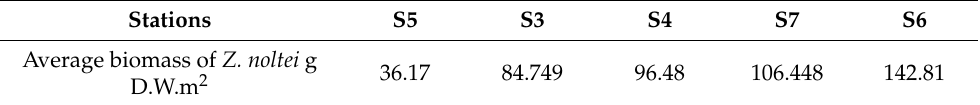
Table 3. The average biomass of Z. noltei in g/m 2 per station in the Merja Zerga lagoon (stations S3, S4, S5, S6, and